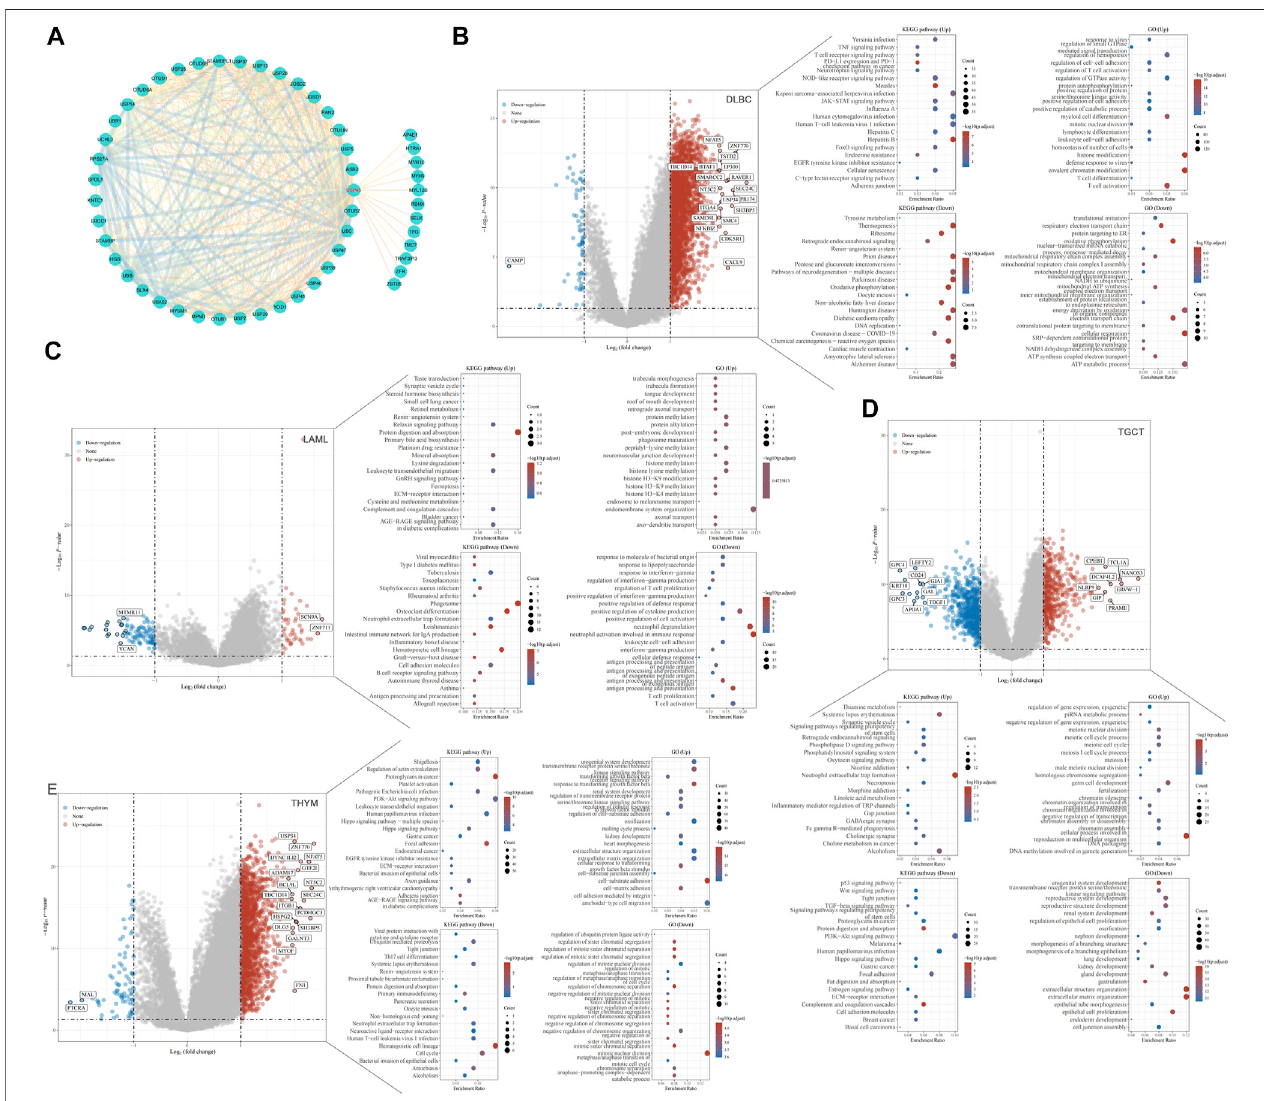
FIGURE9| Constructionoftheprotein-proteininteractionnetworkanddownstreamregulatorynetworkforUSP45. (A) ProteinsthatmayinteractwithUSP45were analyzedbasedonthestringdatabase,andthentheinteraction networkwasvisualizedusingcytoscapesoftware. Inaddition,thethicknessofthelinebetweenproteins represents the score ofprediction. Based on the RNA-seq data in TCGA and GTEx databases, DLBC (B) , LAML (C) , TGCT (D) and THYM (E) were divided into USP45 high expression and low expression groups according to the mean of mRNA expression levels. Then, the upregulated and downregulated genes were screened out using the Limma package of R software, and subjected to GO analysis and KEGG analysis using the ClusterPro fi ler package of R software, respectively.